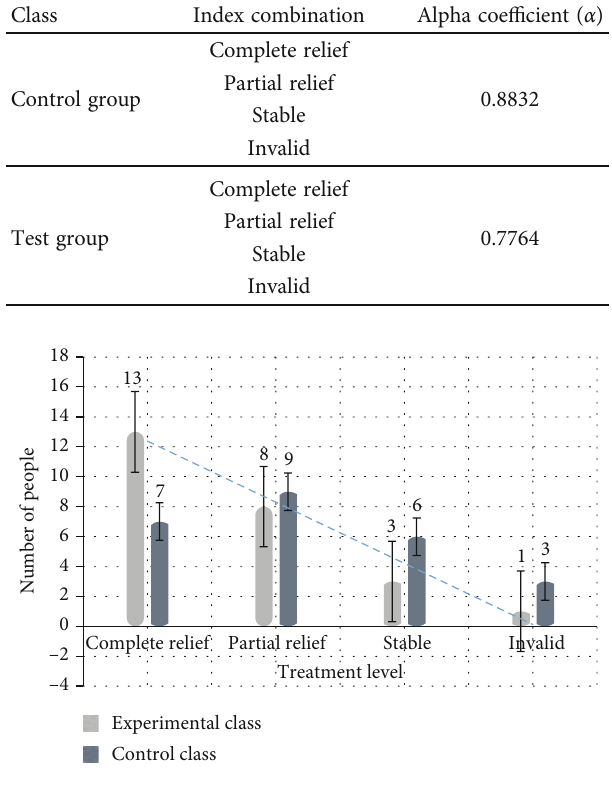
Figure 1: Comparison chart of curative e ff ect during one year of treatment.